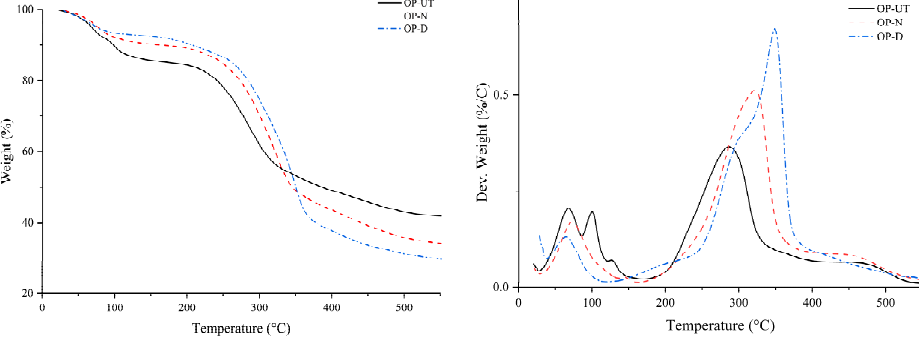
Figure 8. TGA/DTG curves of raw filler (OP-UT) and treated fillers (OP-N and